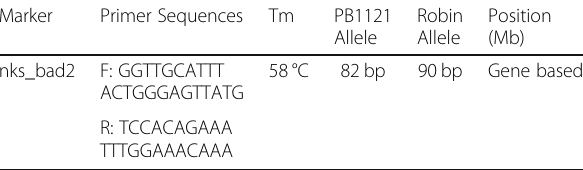
Table 3 Details of nks_bad2 gene based SSR marker for